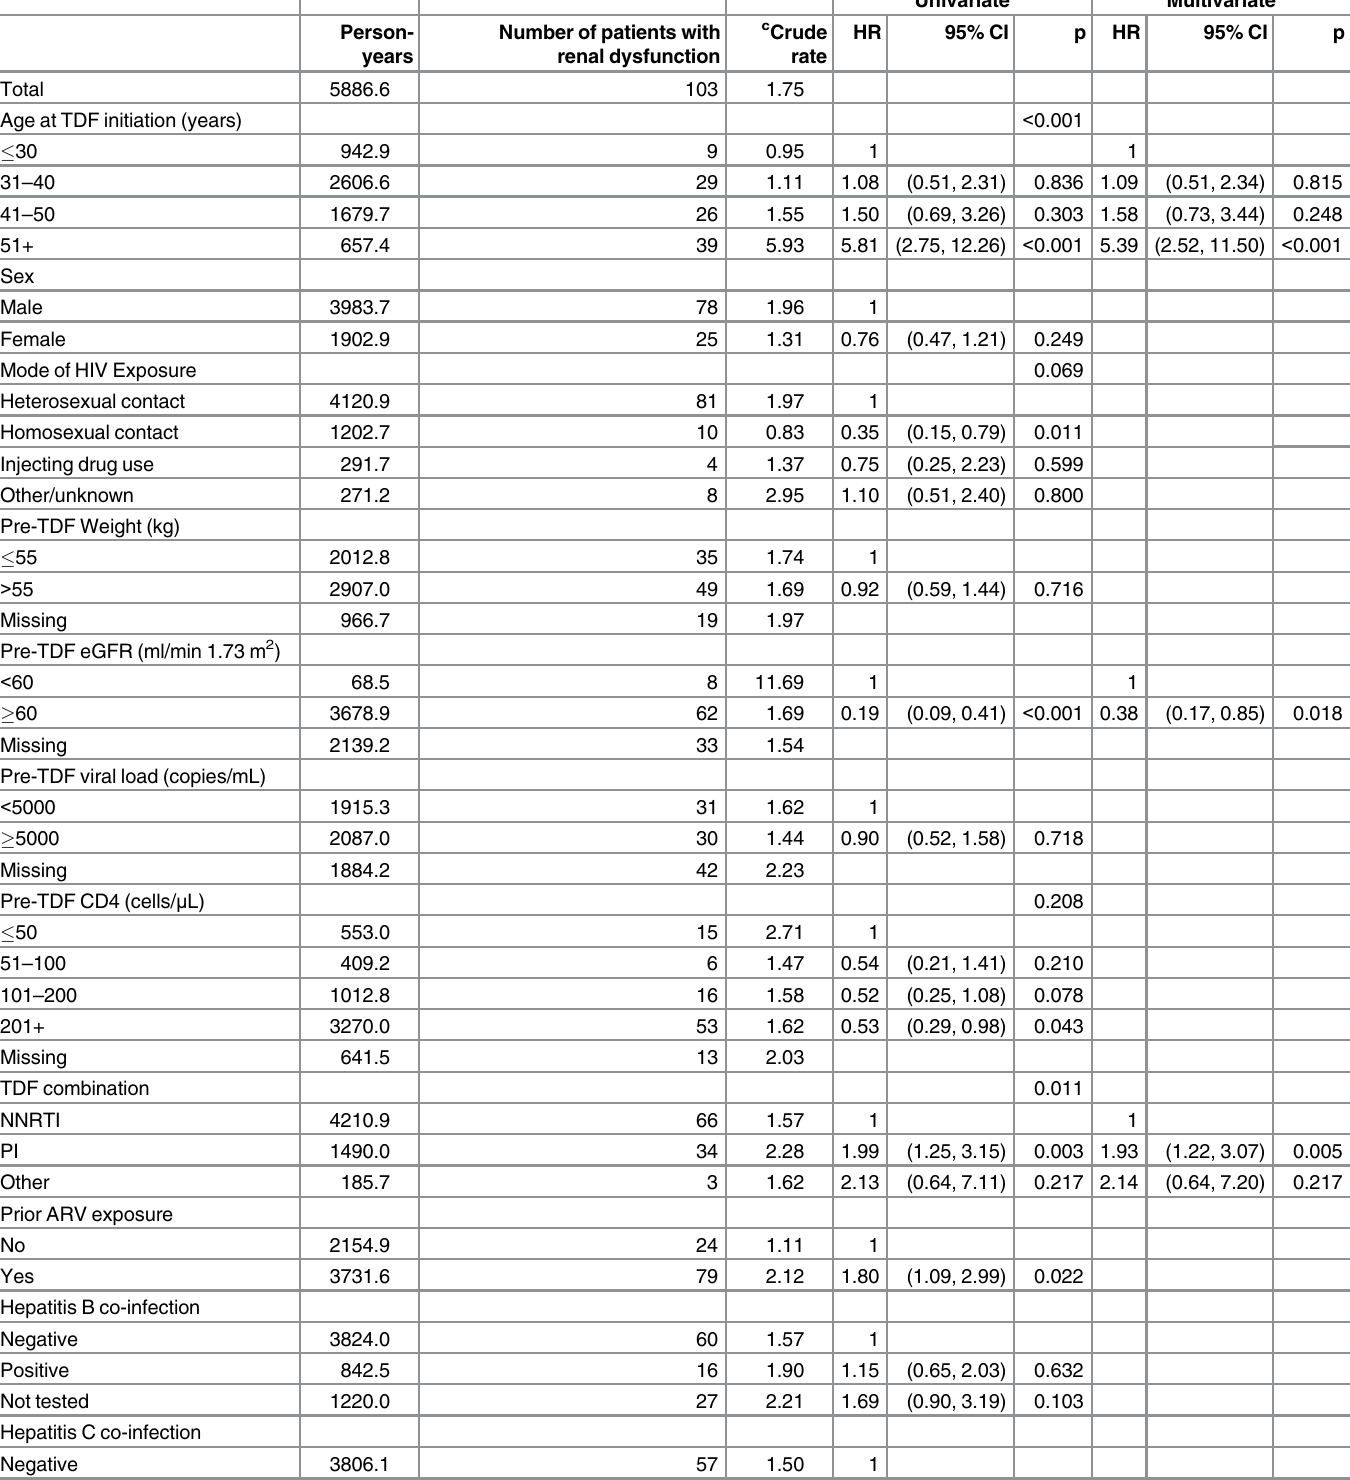
Table 4. Factors associated with time to renal dysfunction during TDF